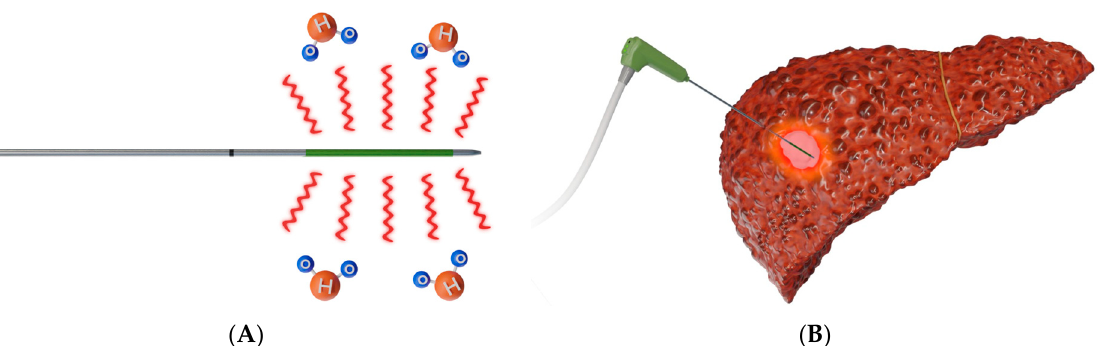
Figure 3. Schematic presentation of microwave ablation. ( A ) Design of a microwave antenna that generates an oscillating electromagnetic field, leading to the continuous realignment of molecules with an intrinsic dipole moment (mostly water) [26]; ( B ) Representative example of MWA used to target a liver tumor.